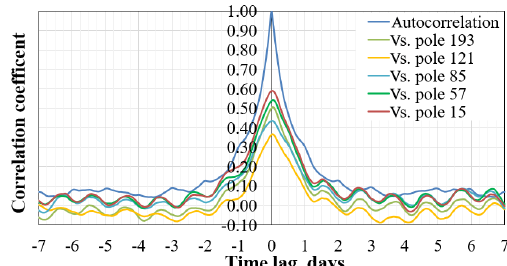
Figure 5. Autocorrelation of wind speed in Rõuste 2 wind farm and cross-correlations of Rõuste 2 vs. line pole stations in one-week time scale.